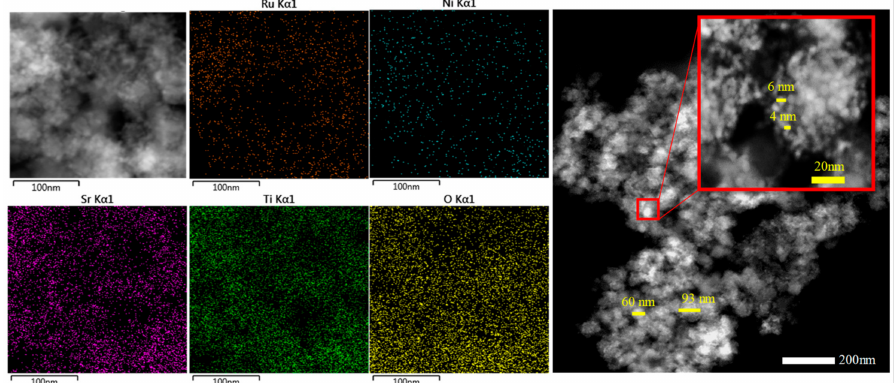
Figure 4. EDS elemental mapping (Sr, Ti, O, Ru, Ni) and TEM images for SrTiO 3 :RuO 2 :NiO photocat- alyst (0.8 wt. % of Ru; [Ru]:[Ni] molar ratio of